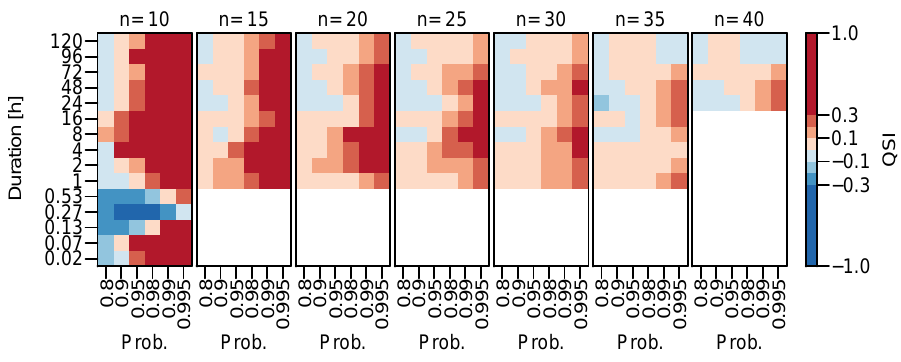
Figure 6. Average Quantile Skill Index QSI d ( p ) at ungauged sites for different durations d and probabilities p , similar to Figure 4. For the spatial d-GEV the data at the respective stations are omitted for fitting, while the reference model uses a different number of years n train in the training set (different columns.)